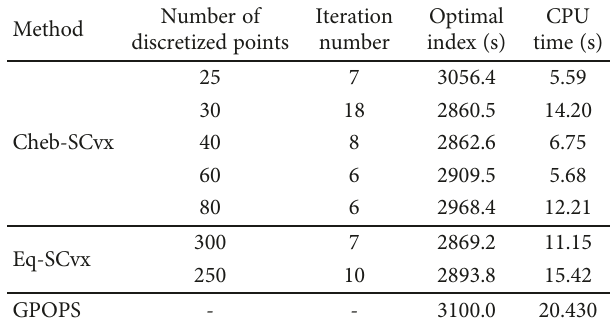
Table 2: Comparison of the minimum-time solution for CAV.